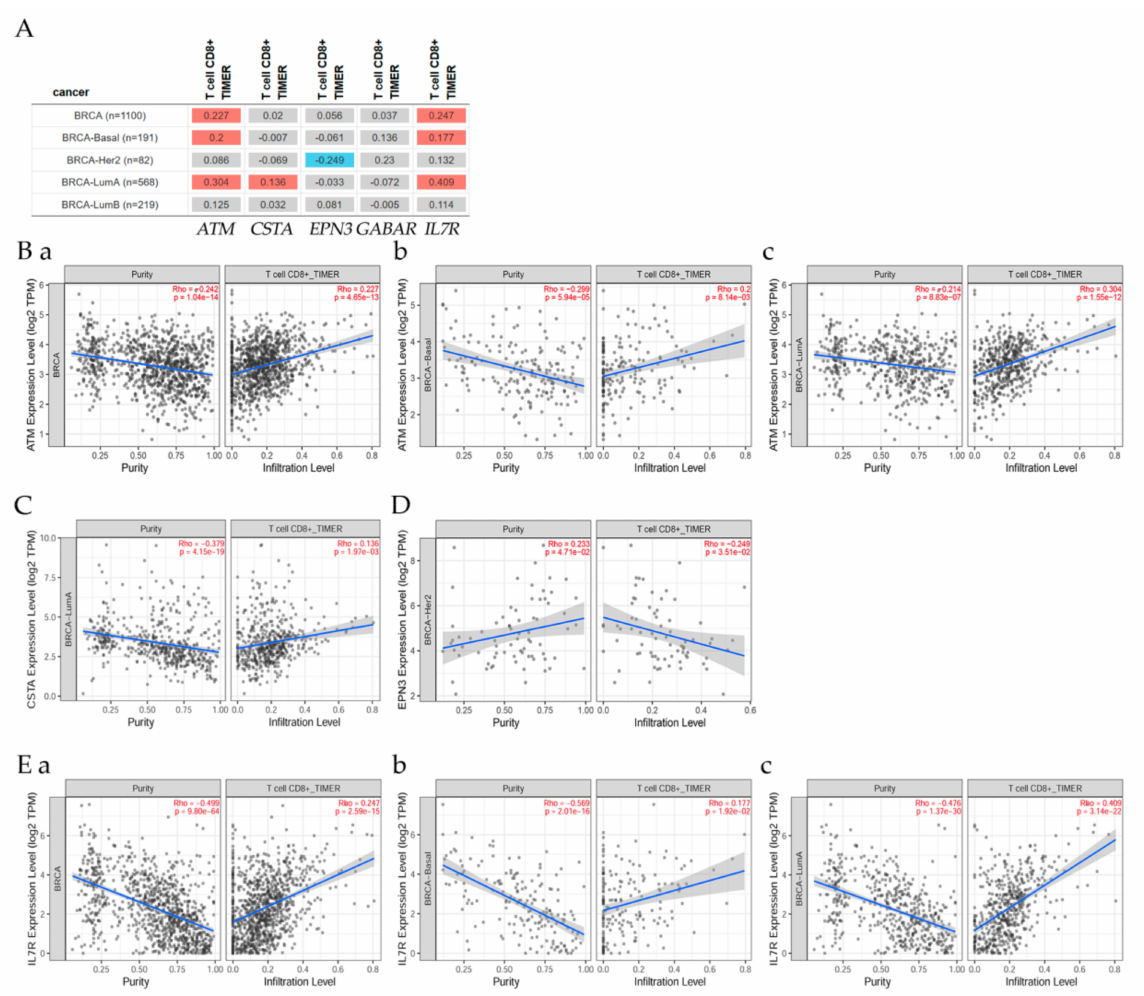
Figure 8. Correlations between gene expression and its immune infiltration levels in diverse breast cancer types. ( A ) The table explores the correlations between gene expression and T cell CD8+ immune infiltrates in BRCA patient types. These figures show the correlation between T cell CD8+ and ( B ) ATM in ( a ) all BRCA, ( b ) BRCA-Basal, and ( c ) BRCA-LumA, ( C ) CSTA in BRCA-LumA, ( D ) EPN3 in BRCA-Her2, ( E ) IL7R in ( a ) all BRCA, ( b ) BRCA-Basal, and ( c )